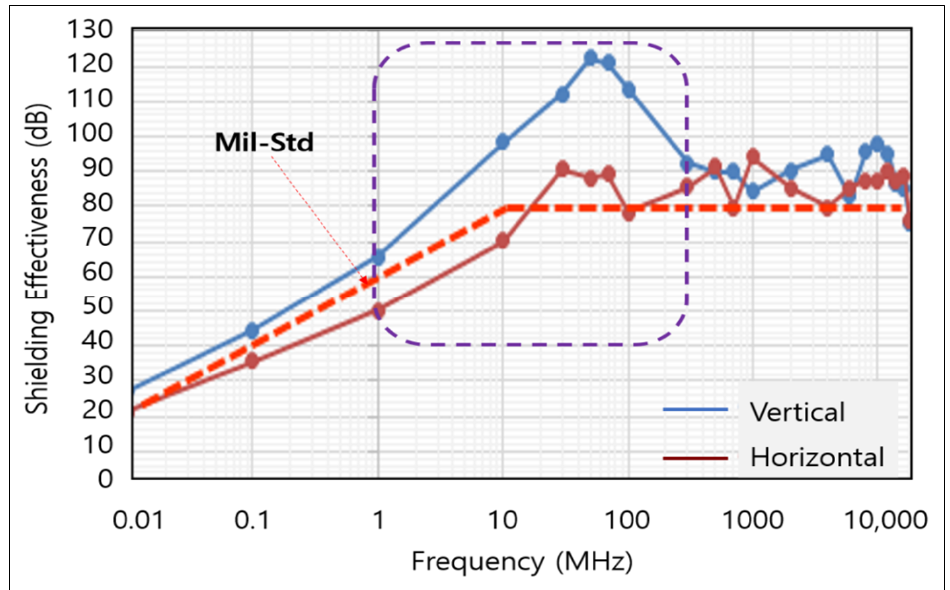
Figure 6. Shielding effectiveness of specimen #3 (W = 50).